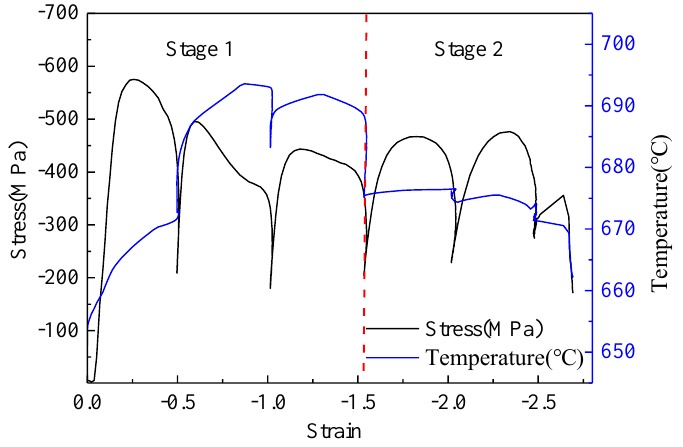
Figure 2. Temperature and flow stress curves variation during multi-pass deformation.